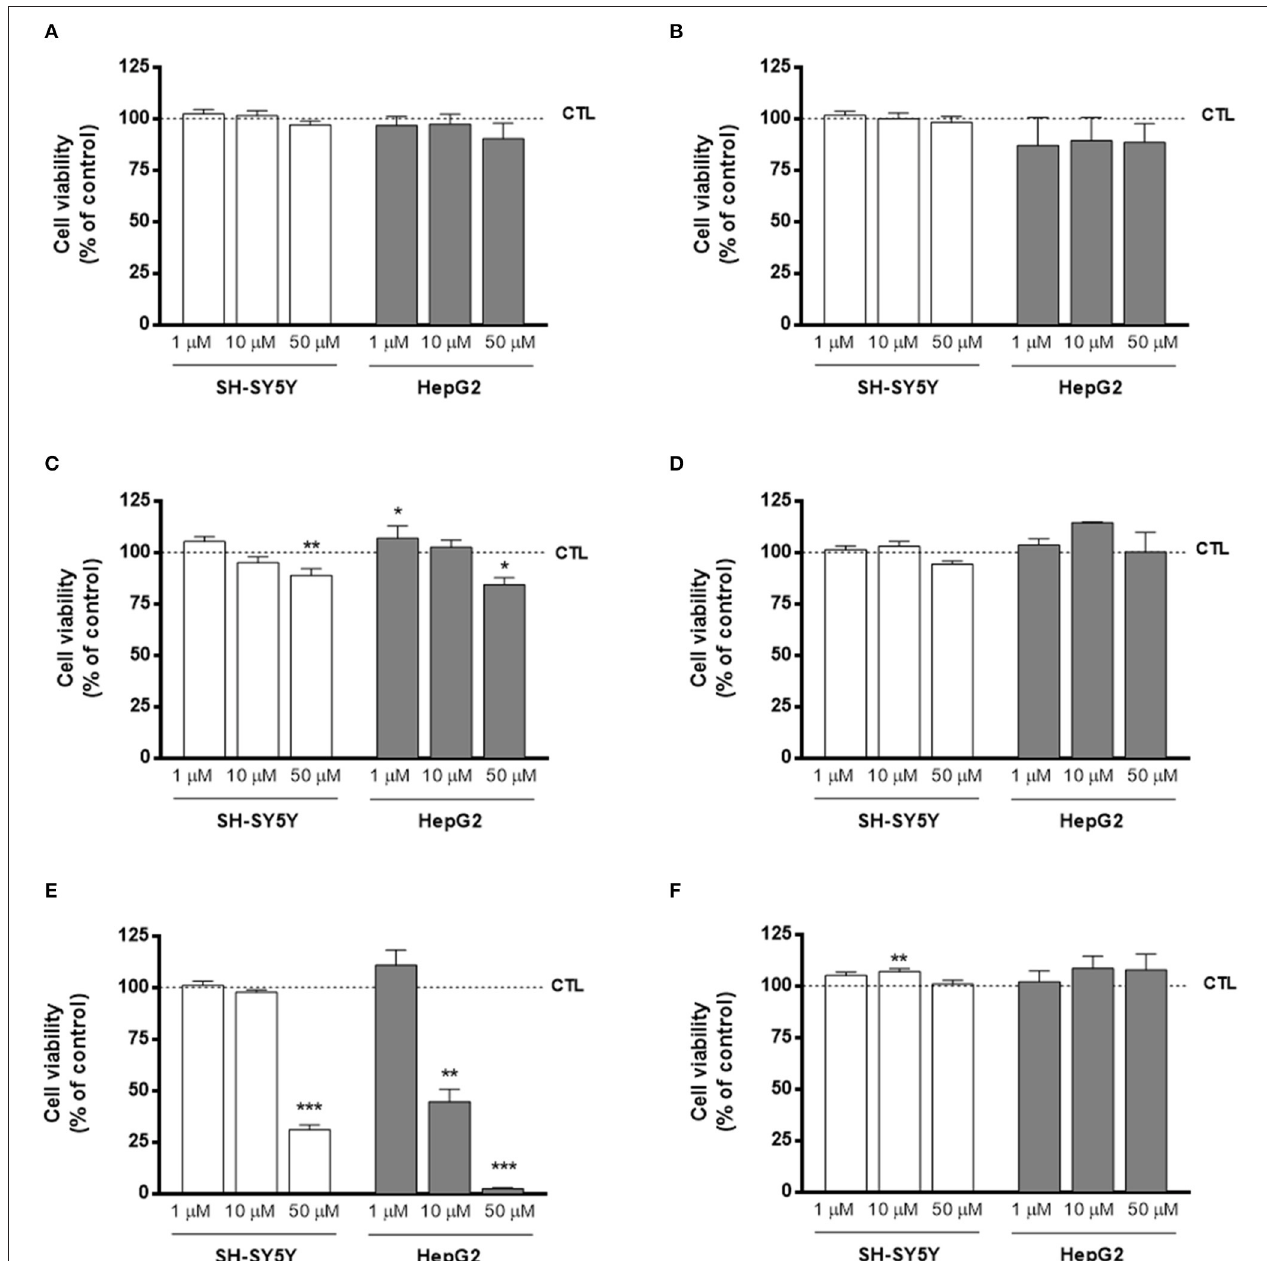
FIGURE 2 | Cytotoxicity profile of compounds (A) AntiOxBEN 1 , (B) AntiOxBEN 2 , (C) 15 , (D) 16 , (E) 17, and (F) 18 measured by changes in cellular metabolic activity on human neurablastoma SH-SY5Y and human hepatocarcinoma HepG2 cells after 24 or 48h treatment time, respectively, at three different concentrations (1, 10, and 50 µ M). Cellular viability was evaluated using two methods: MTT in differentiated SH-SY5Y and resazurin reduction assays in HepG2 cells. Untreated cells were used as control. Data are means ± SEM of three independent experiments and the results are expressed as percentage of control (control = 100%), which represents the cell density without any treatment in the respective time point. Significance was accepted with * P < 0.05, ** P < 0.01, *** P < 0.0005 vs. control.